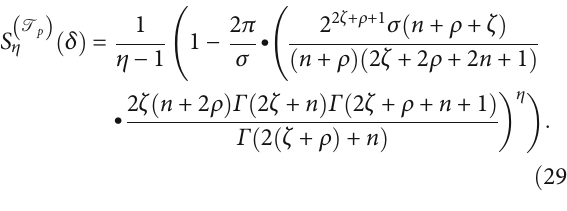
ϱ = 0.10 ϱ = 0.15 Figure 5: The function of energy spectral with regard to n with μ = c = ℏ = 1 , Η = 20 , Τ = 15 , D = 3 , and σ = 0 : 1 for ϱ = 0 : 1 , 0.15, and 0.20.